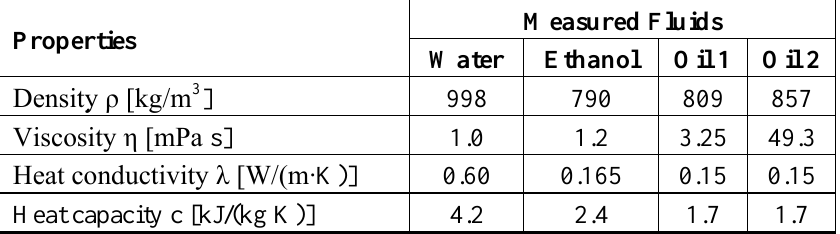
Table 1. Properties of the liquids employed for the